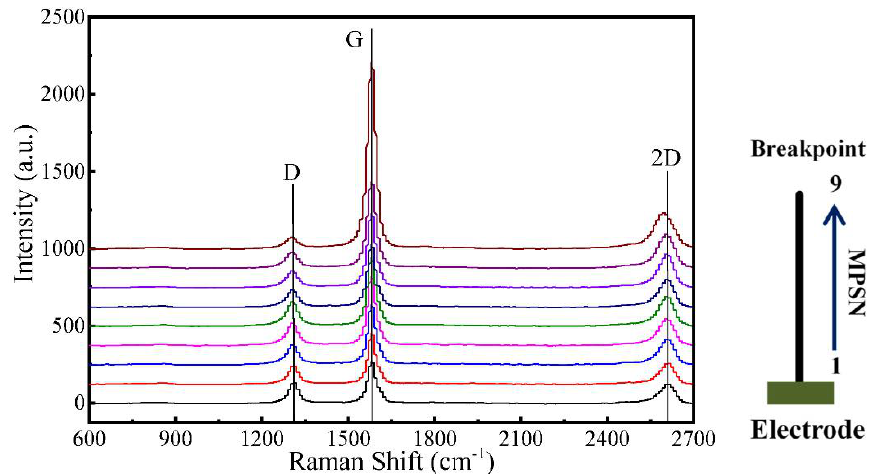
Figure 9. The Raman spectrum with measuring point positions 1–9 of the burned CNTB sample. Point 1 is the furthest from the breakpoint, and 9 is the closest.